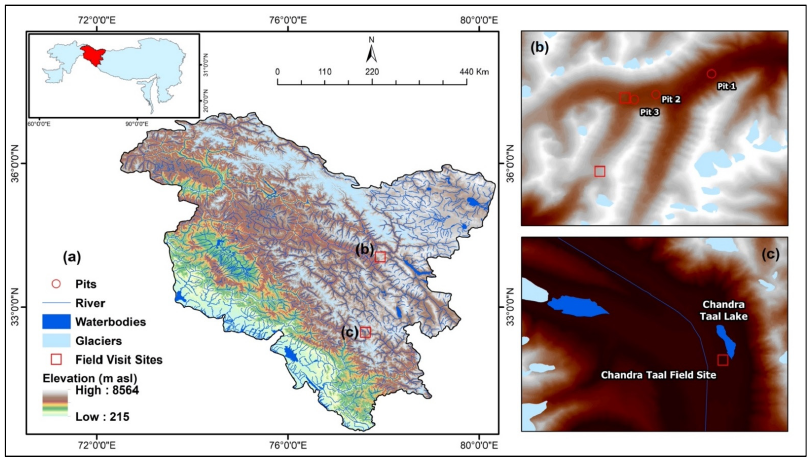
Figure 1. The map showing the ( a ) location of the study area (highlighted in red) in the HKH region (inset boundary by ICIMOD [72]) with elevation after Shuttle Radar Topographic Mission (SRTM), glaciers [73], water bodies [74] and ground validation sites in ( b ) Ladakh and ( c ) Himachal Pradesh.